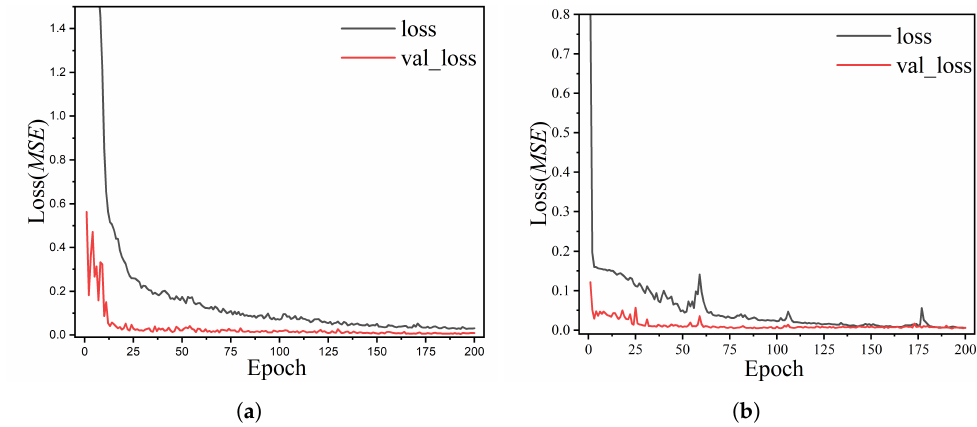
Figure 3. LSTM model training results: ( a ) rainy period; ( b ) dry period.